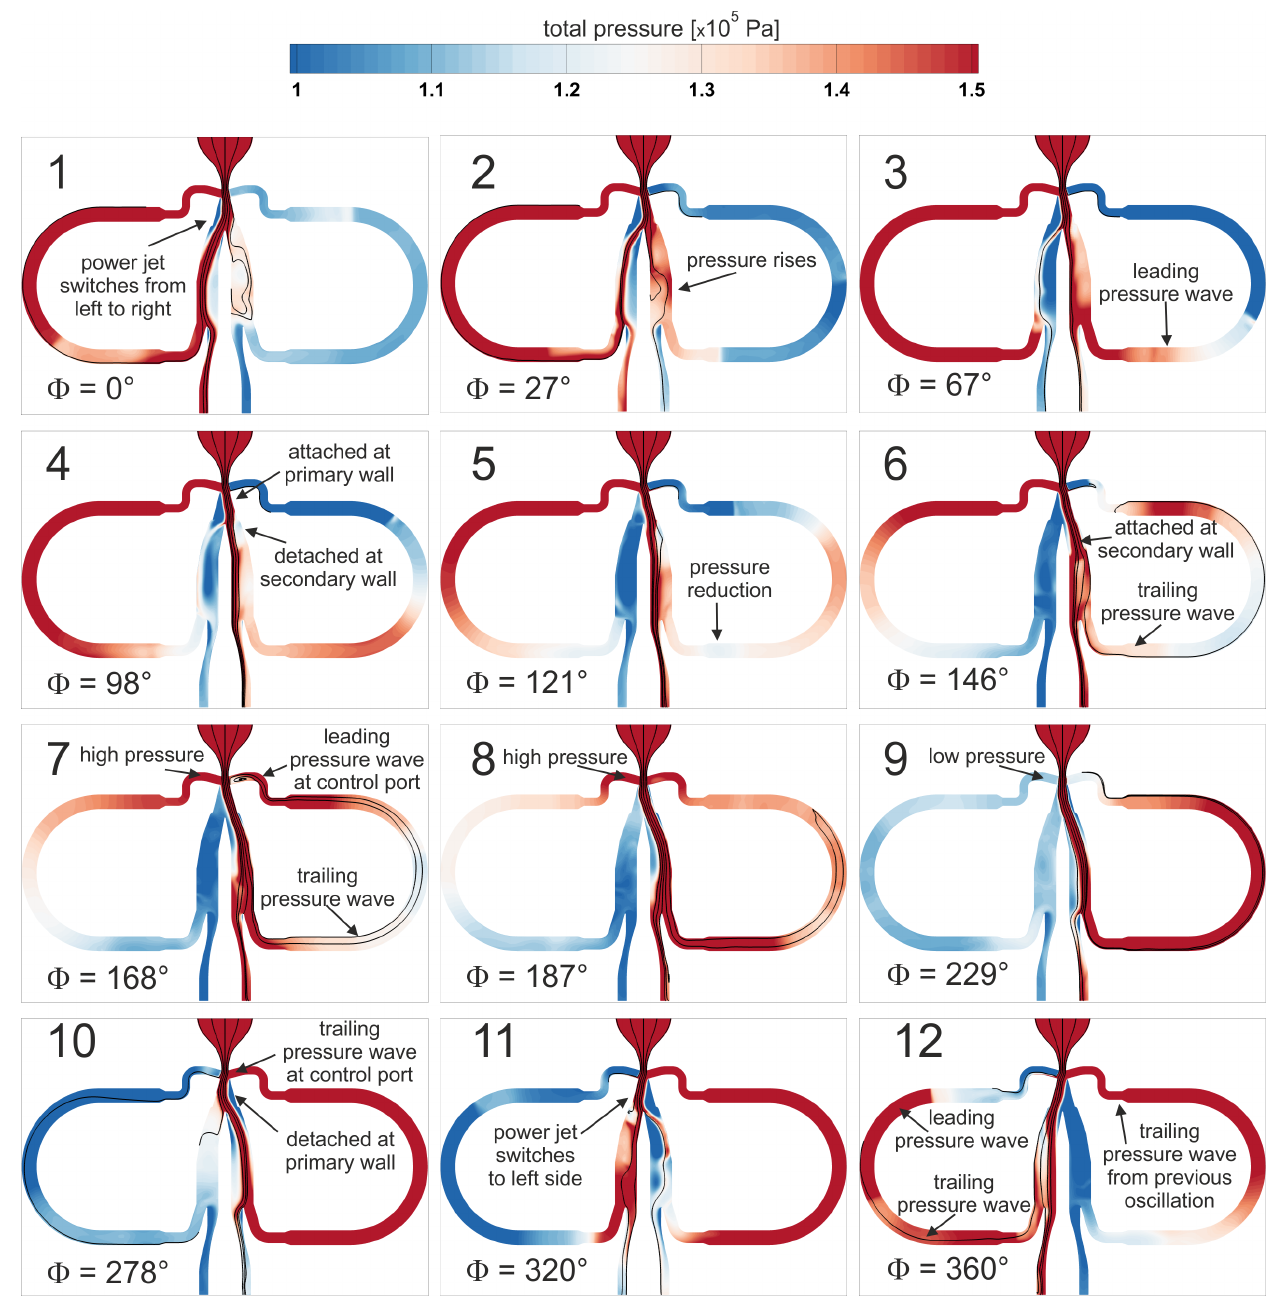
Figure 12. FO-PJA switching process, fundamental regime, Φ is the phase angle during one